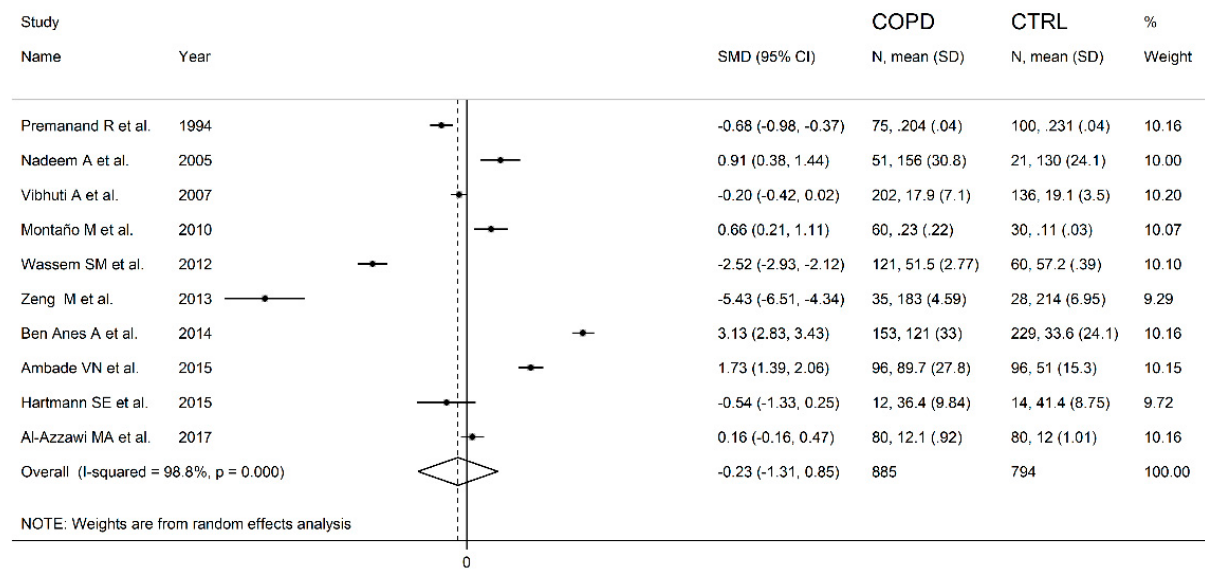
Antioxidants 2021 , 10 , x FOR PEER REVIEW